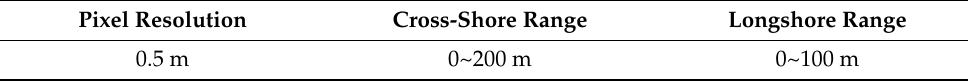
Table 2. Configuration of orthoimages of a single video.